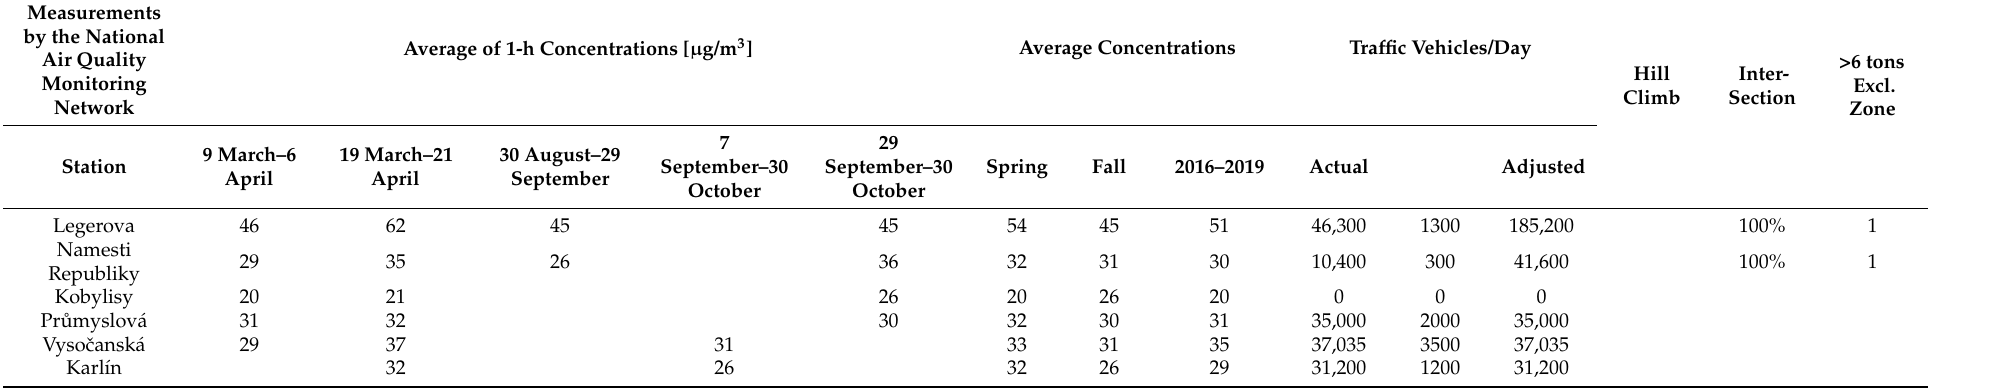
Table 2. Measured NO 2 concentrations and average daily vehicle counts—monitoring